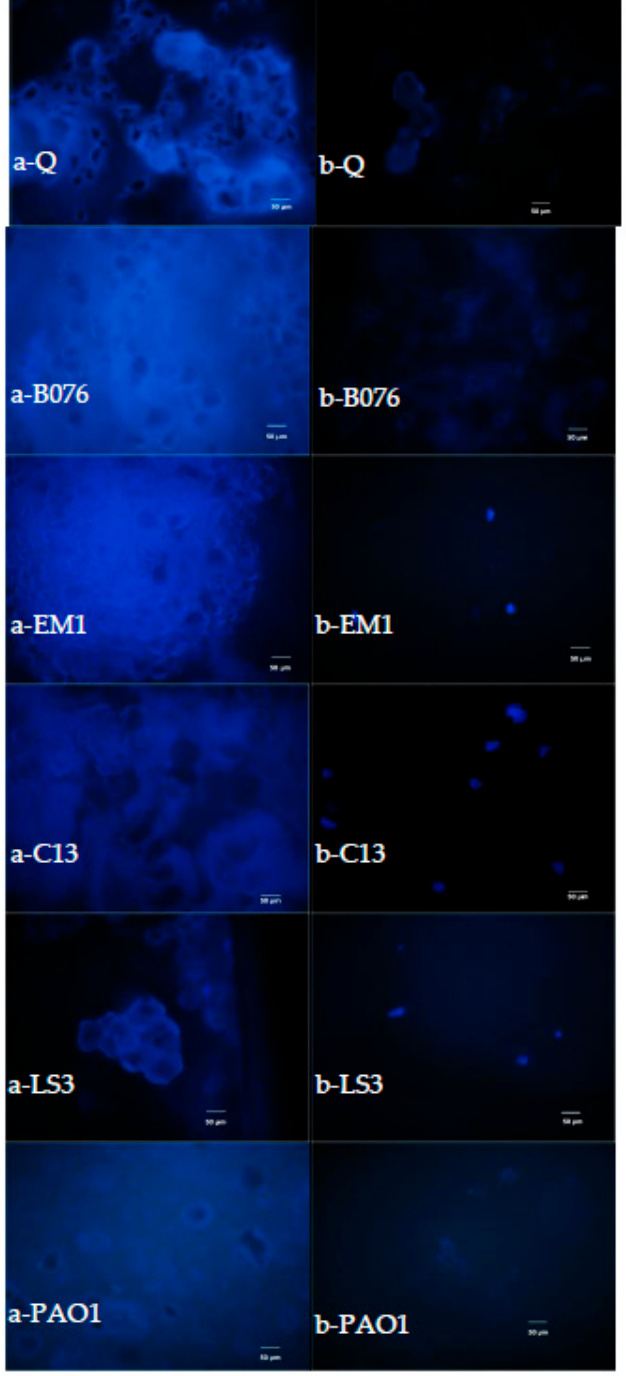
Figure 5. Calco fl uor staining of EPS in bio fi lm formed by phytopathogenic P. syringae strains and P. aeruginosa PAO1. ( a ) Untreated control; and ( b ) treatment with TEO. aeruginosa PAO1. ( a ) Untreated control; and ( b ) treatment with